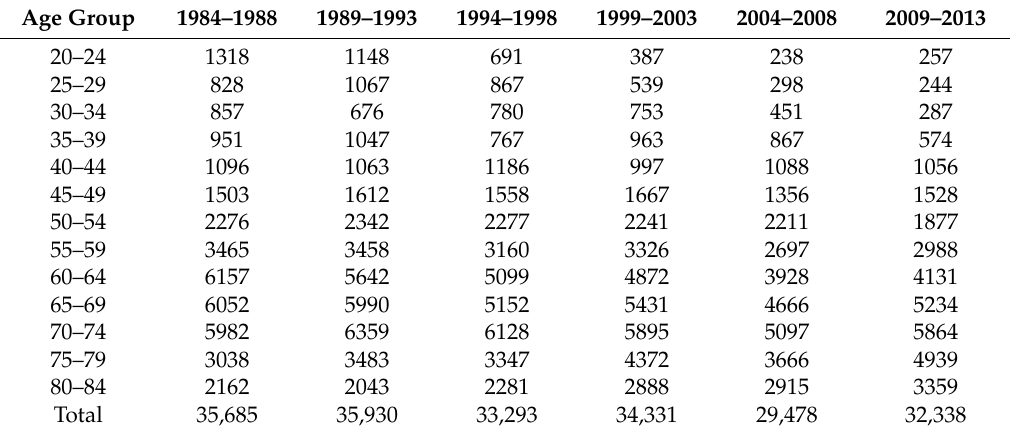
Table A1. Age-specific all-cause deaths during 1984–2013 in Macheng City.